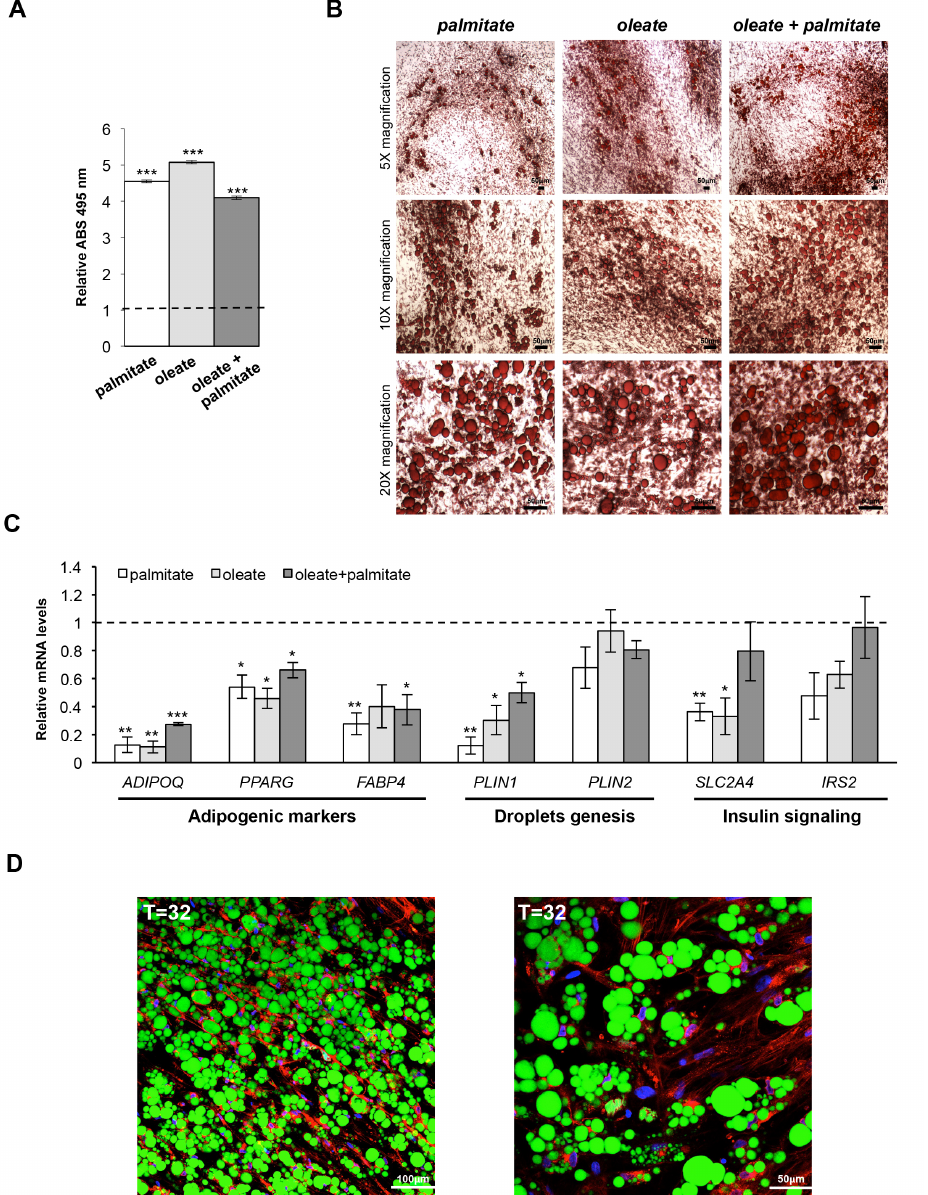
Figure 3. Hypertrophic-like cells generated from hMSCs-derived adipocytes. ( A ) Optical determination of lipid accumulation (Oil Red O staining) in hypertrophic-like adipose cells (HAs) generated from matureadipocytes(MAs)—di ff erentiatedin vitrobyhMSCs—bysupplementationofthreedi ff erentfatty acids mixes. Data are shown as mean ± SEM compared to mature adipocytes from three